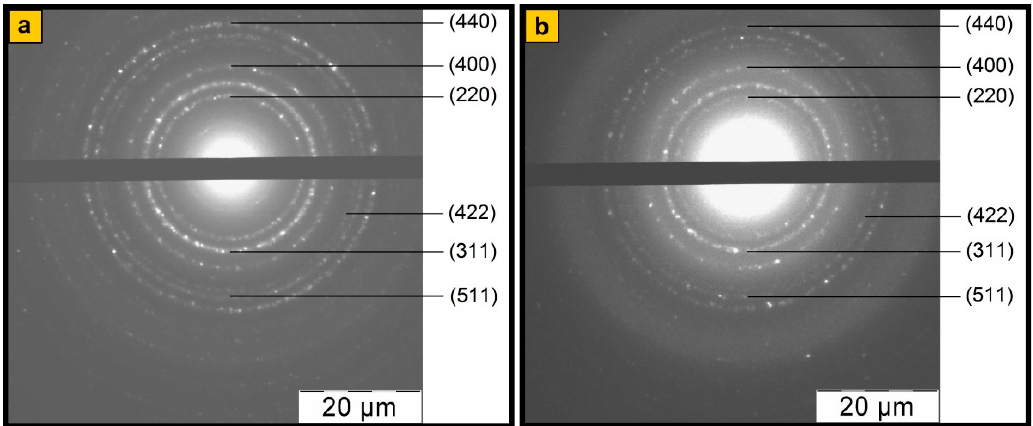
Figure 3. Fe 3 O 4 di ff raction images of Fe 3 O 4 / SWCNT / PDPAC, prepared in alkaline ( a ) and acidic media ( b ).